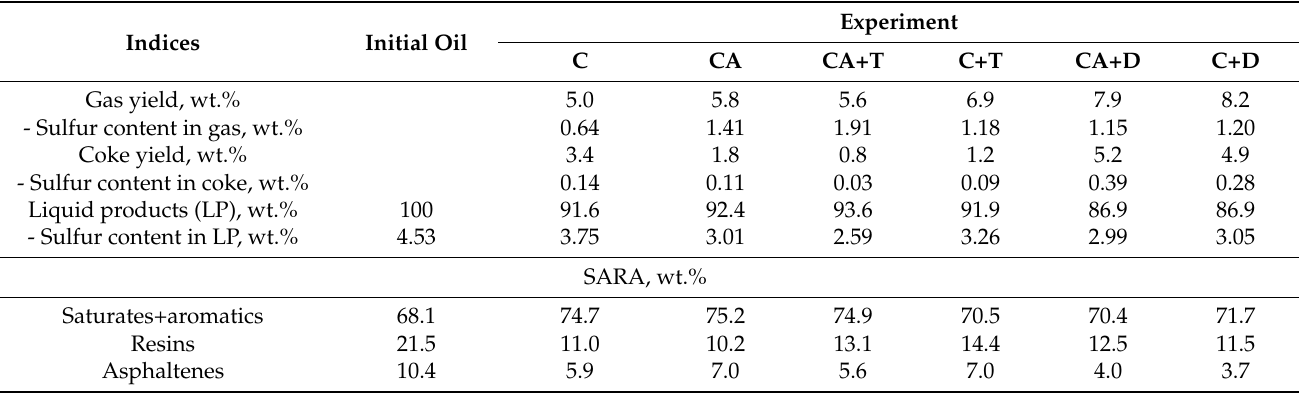
Table 1. Yield of products in the catalytic aquathermolysis of heavy oil in the presence of hydrogen